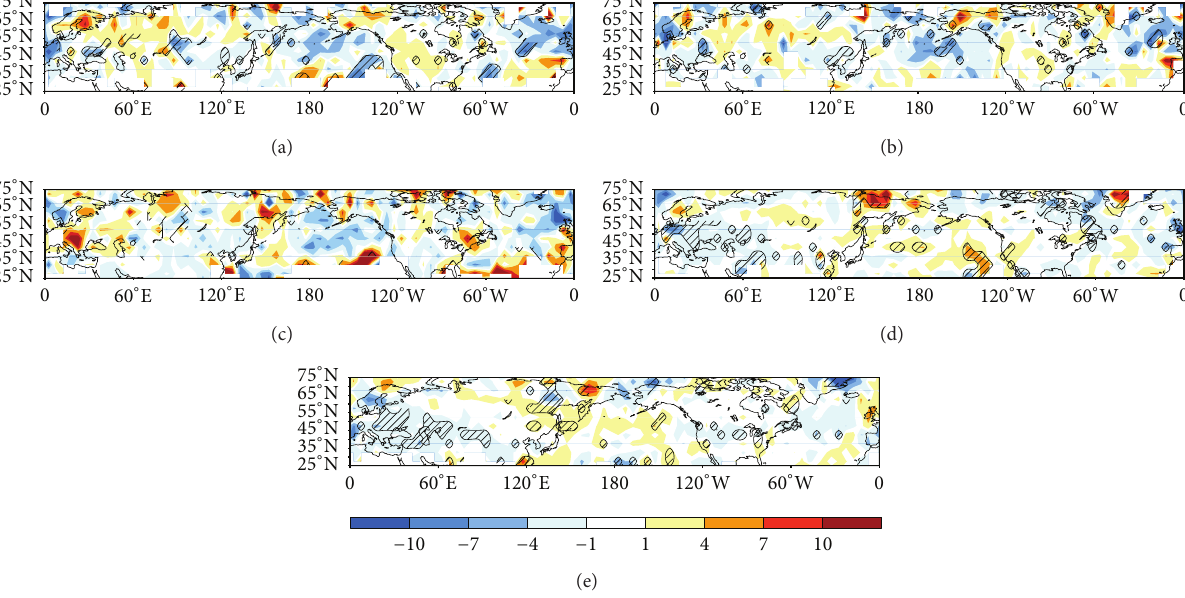
Figure 11: NH storm track intensity composite (hPa) in OND for (a) DMI positive relative to DMI negative (shaded) 95% significance (hatched) for (a) NCEP1, (b) like (a) but for ERA40, (c) like (a) but for CFSR, (d) like (a) but for CMIP1, and (e) like (a) but for